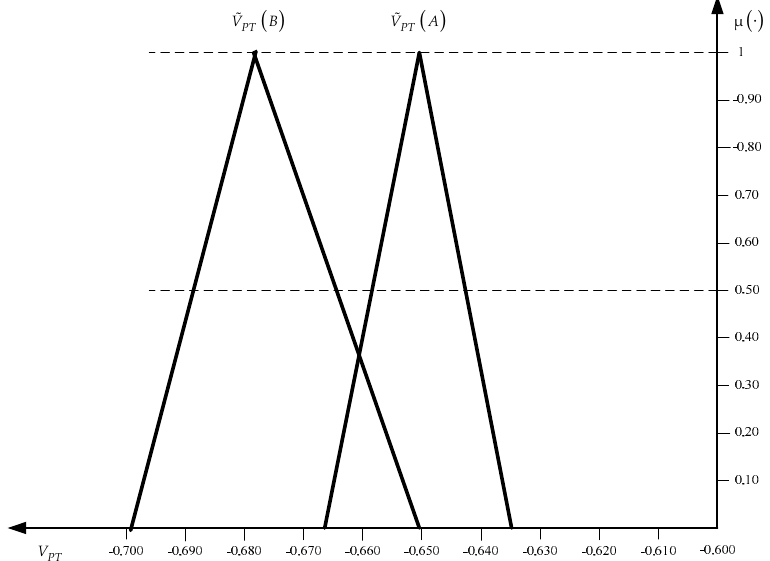
Figure 8. Graphs of the membership functions of the generalized fuzzy values (cid:101) V PT ( A ) , (cid:101) V PT ( B ) .